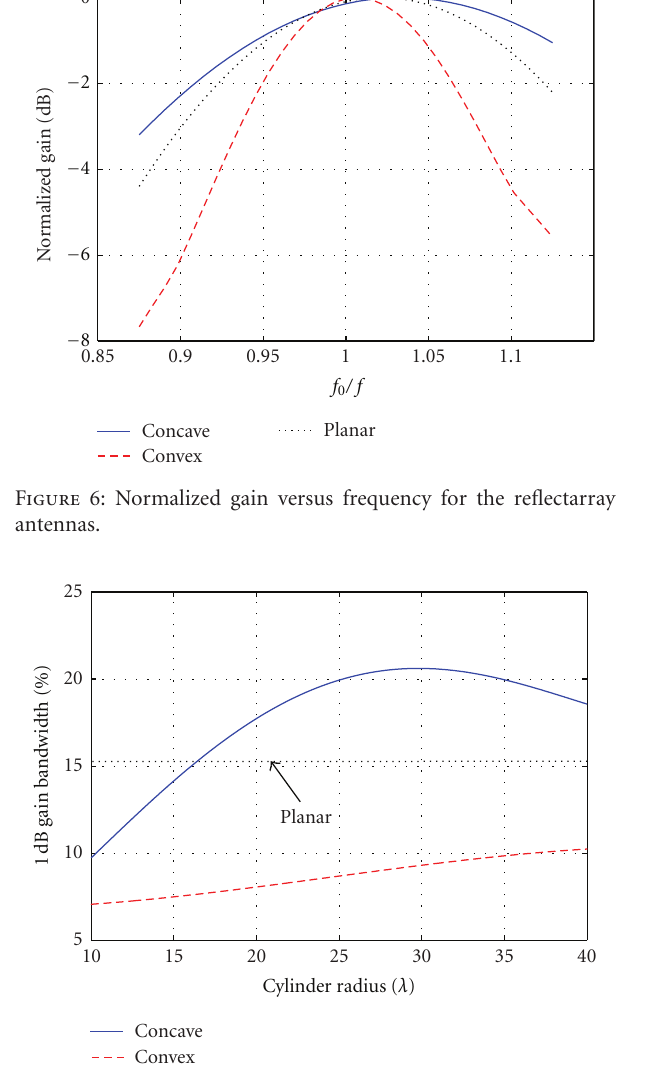
Figure 7: Gain bandwidth of the reflectarray antennas as a function of cylinder